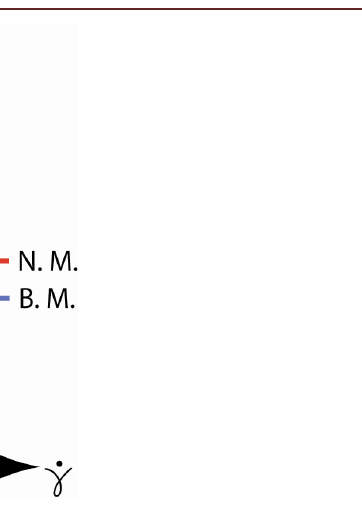
Figure 3: Newton and Bingham models